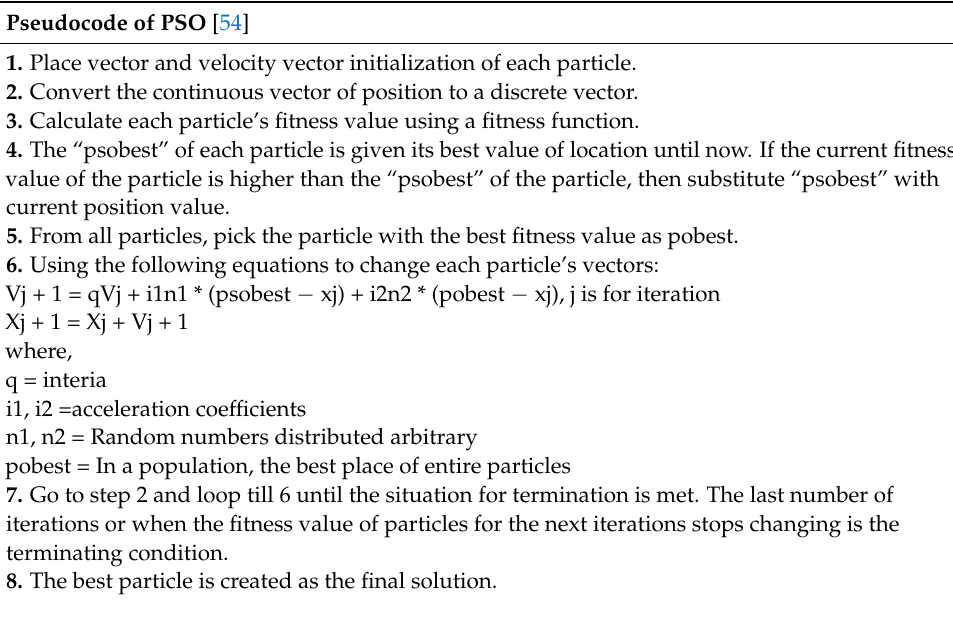
Figure 6. Particle swarm optimization flowchart [41].